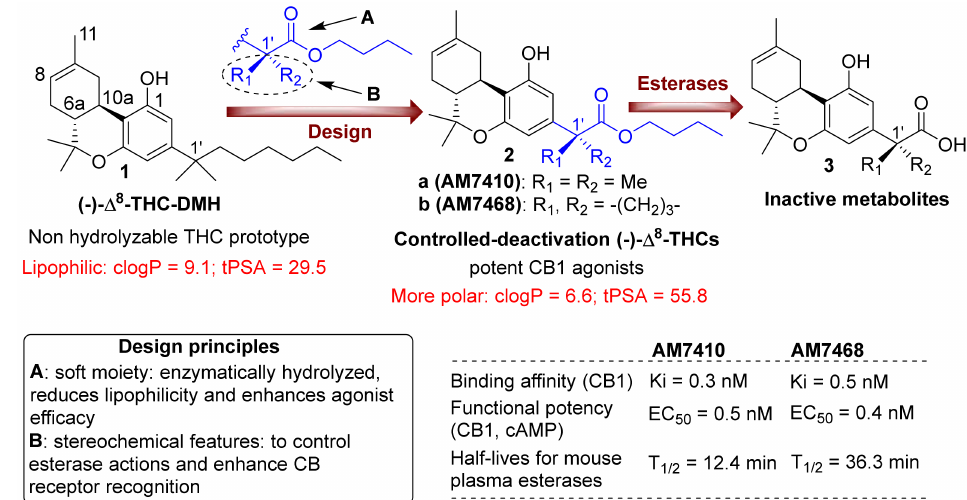
Figure 1. Top panel: design of first-generation side chain carboxylated cannabinoid analogs, with controllable deactivation and increasing polarity, and structures of the prototype (-)- ∆ 8 -THC-DMH and inactive metabolites. Lower panel: design principles and biological activity data for representative